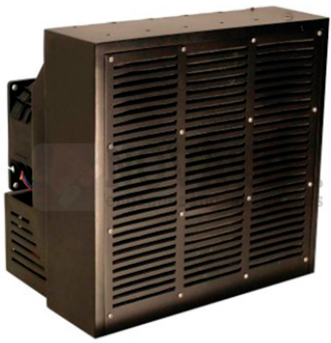
Figure 11. AEROSTAK Horizon fuel cell stack.